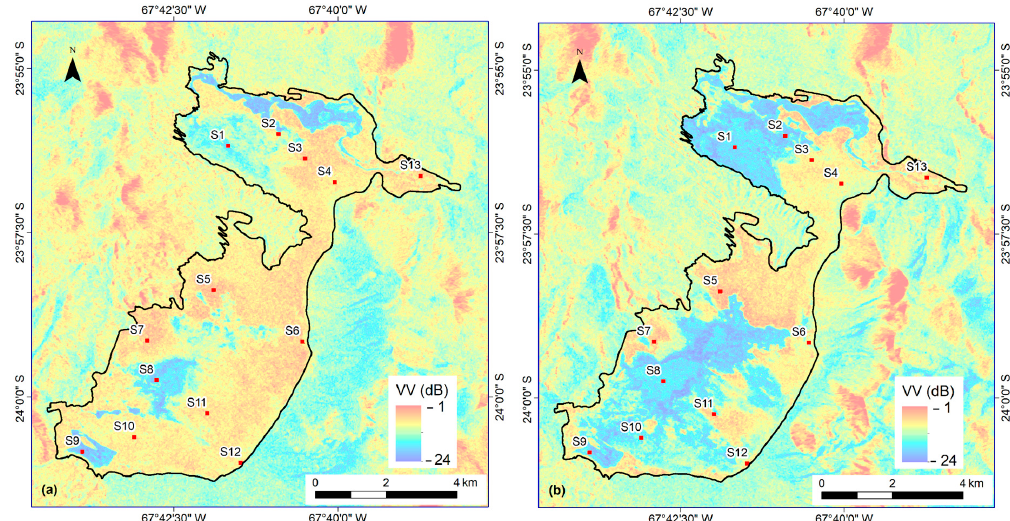
Figure 9. ( a ) Sentinel 1A, VV polarization, descending orbit (9 March 2015). High backscattering coefficient accounted for well-developed salt crusts formed by capillarity over dry periods before La Niña, ( b ) Sentinel 1A, VV polarization, ascending orbit (13 April 2015). Extreme rainfall event left vast areas with a smoothened surface after salts dissolved. Intense southeast winds caused standing water to depart from flooded areas to dry areas. The opposite also occurred with loose soil particles from dry areas to flooded